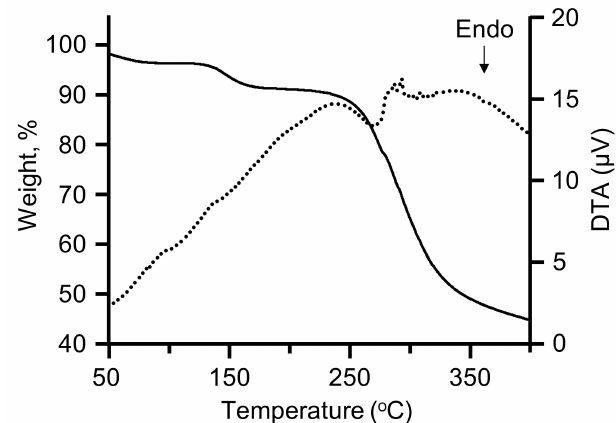
Figure 6. Thermogravimetric–differential thermal analysis curve of as-spun (nondrawing) regener- ated silk fibroin